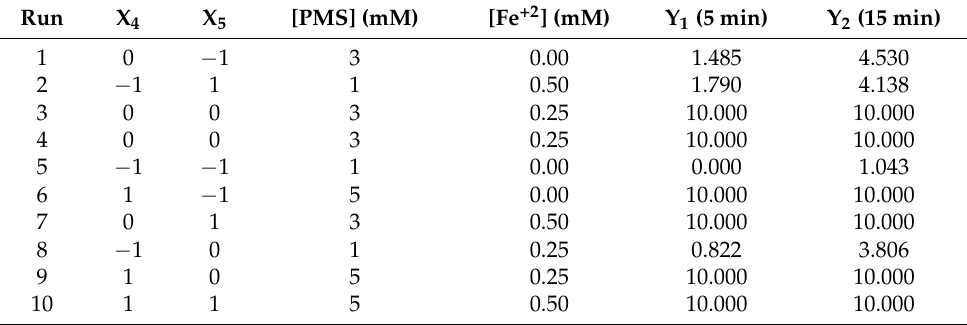
Table 4. Arrangement of CCD for the three independent variables used in